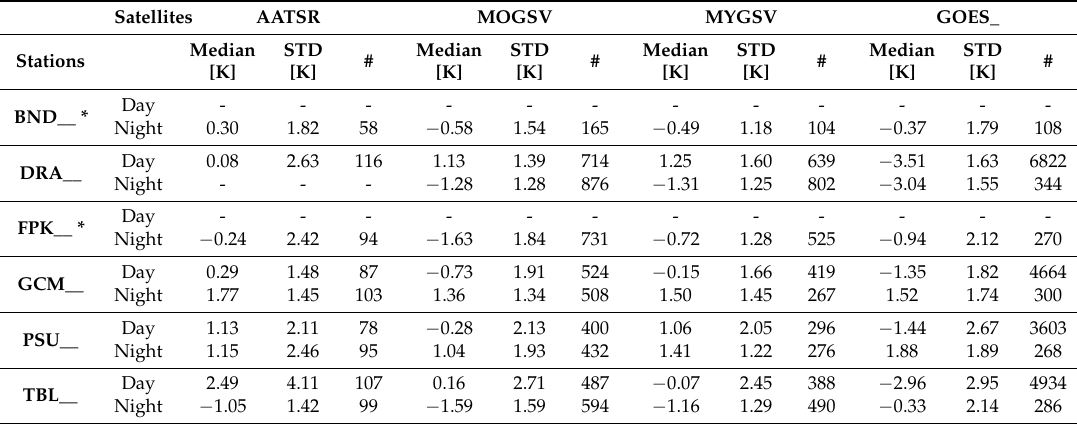
Figure 9. Number of averaged data points used for the validation for years 2010–2012. The upper plot displays the daytime and the lower plot the night-time data. BND and FPK daytime data were excluded from the validations due to a very strong seasonal cycle. Table 3. Median validation accuracy, STD, and number of data points (#) over the SURFRAD stations for all satellites, for the years 2010–2012.